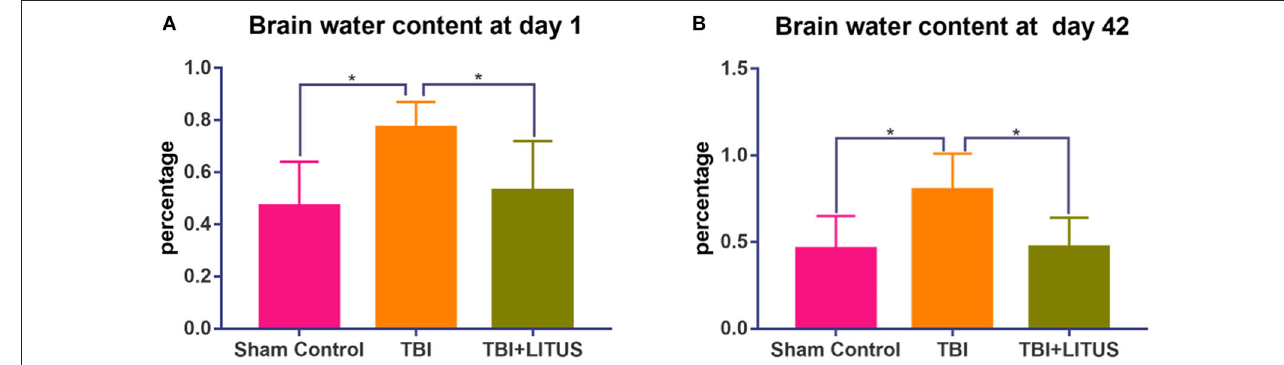
FIGURE 9 | Water content of TBI and TBI + LITUS groups. (A) Brain water content at day 1. (B) Brain water content at day 42. Data are mean ± SD, n = 5, respectively, for the two time points. Tukey’s post-hoc test for TBI vs. TBI + LITUS. Unpaired t -test, * P <